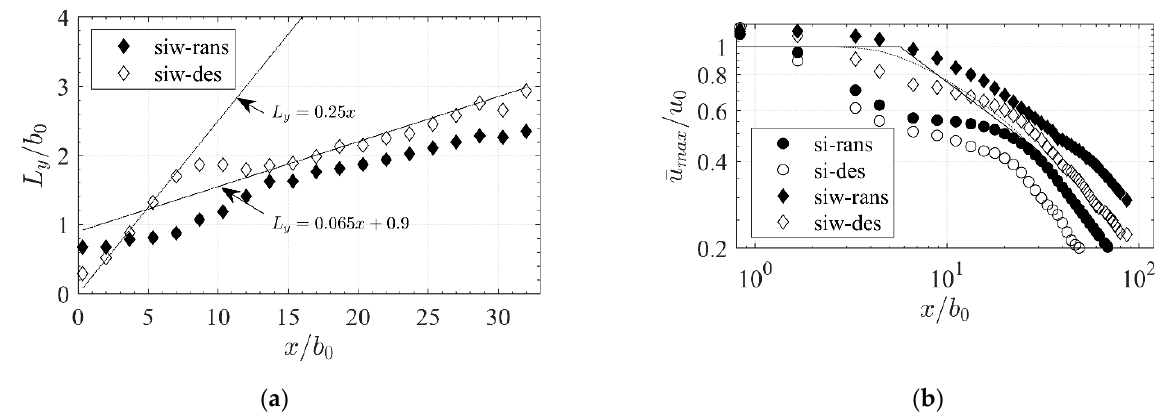
Figure 16. Downstream evolution of si and siw jets: ( a ) half-width growth at z = 0.5 h 0 . and ( b ) decay of the mean maximum streamwise velocity u max / u 0 in yz-planes in distances from the